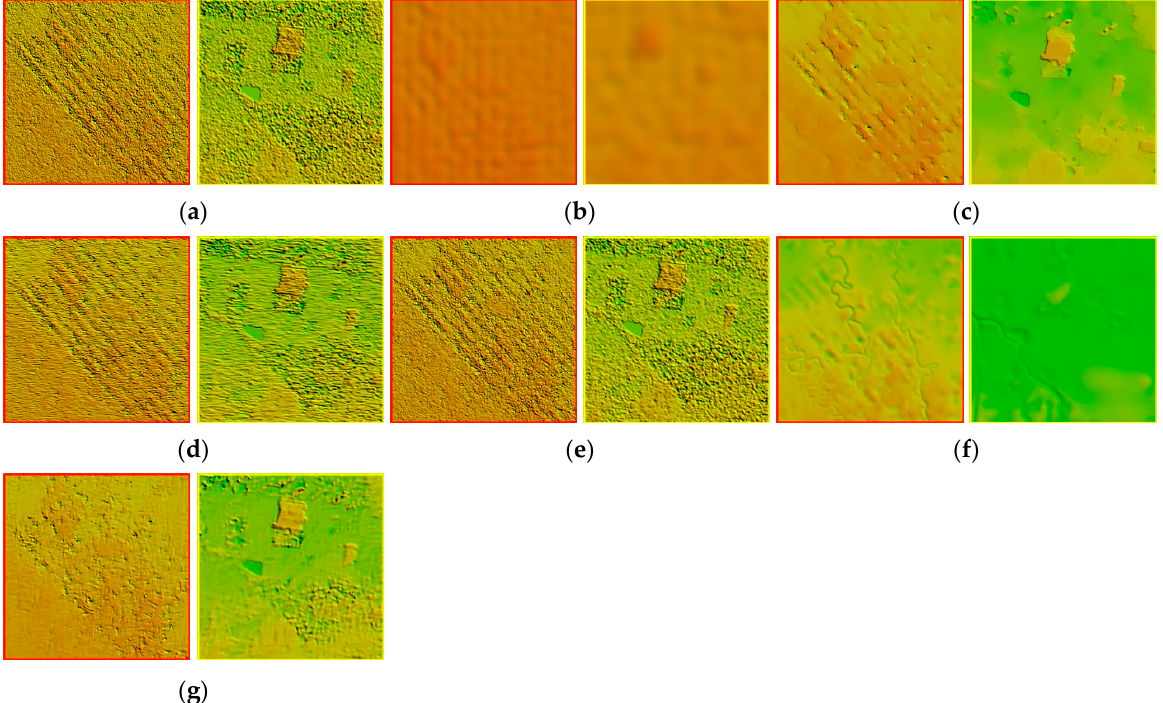
Figure 10. Results of the real experiment for the local enlargement of area S31E147 (Figure 9). Local enlargements for ( a ) area S31E147, ( b ) low-pass filter, ( c ) TV, ( d ) UTV, ( e ) LRSID, ( f ) Gallant and ( g ) LRGS.